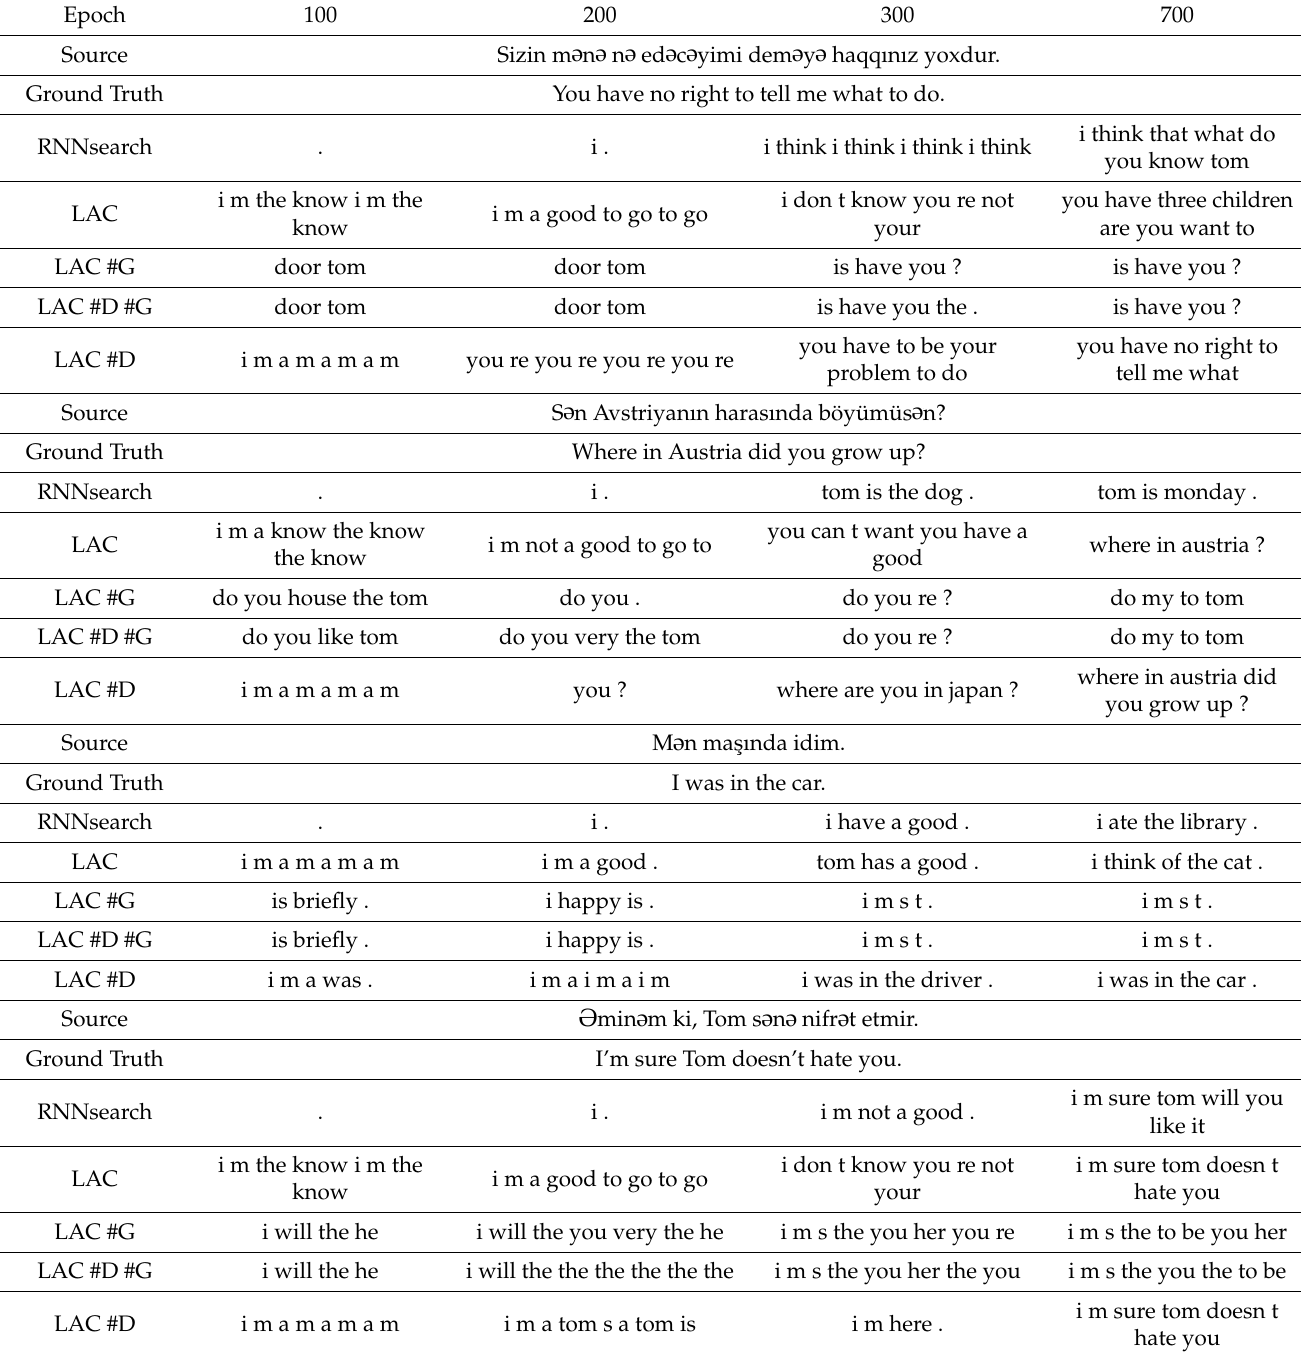
Table 7. Azerbaijan-English.